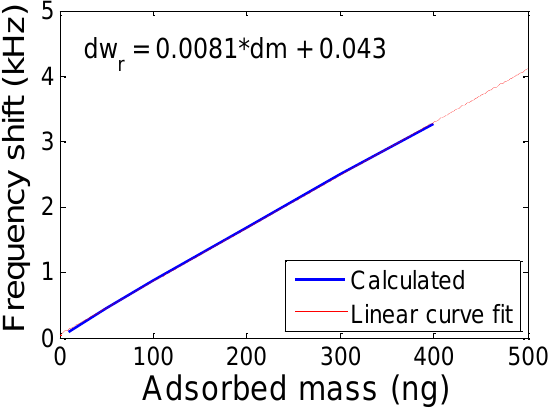
Figure 12. Quantification of frequency shift as a result of adsorbed mass exploiting mathematical modeling